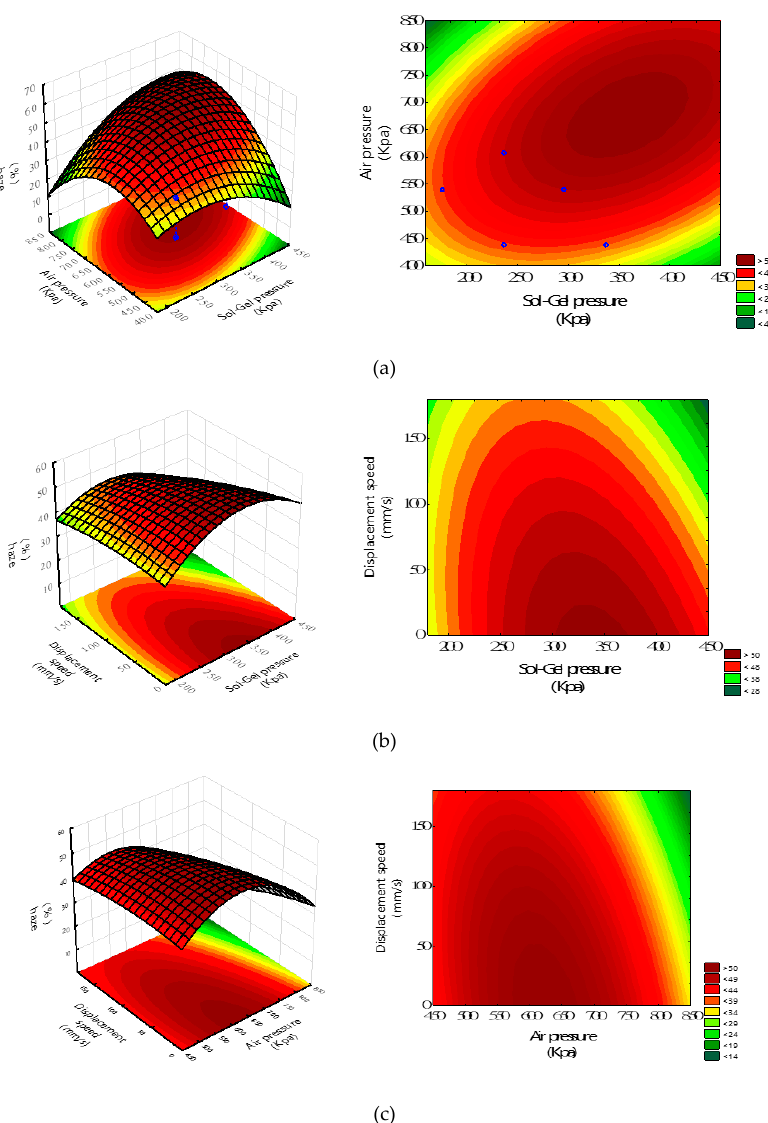
Figure 10. The response surface plots of haze against the factors of ( a ) sol-gel deliver pressure (X 1 ) and air transport pressure (X 2 ) with X 3 of 20 mm/s; ( b ) displacement speed (X 3 ) and sol-gel deliver pressure (X 1 ) with X 2 of 620 kPa; and ( c ) displacement speed (X 3 ) and air transport pressure (X 2 ) with X 1 of 340 kPa.